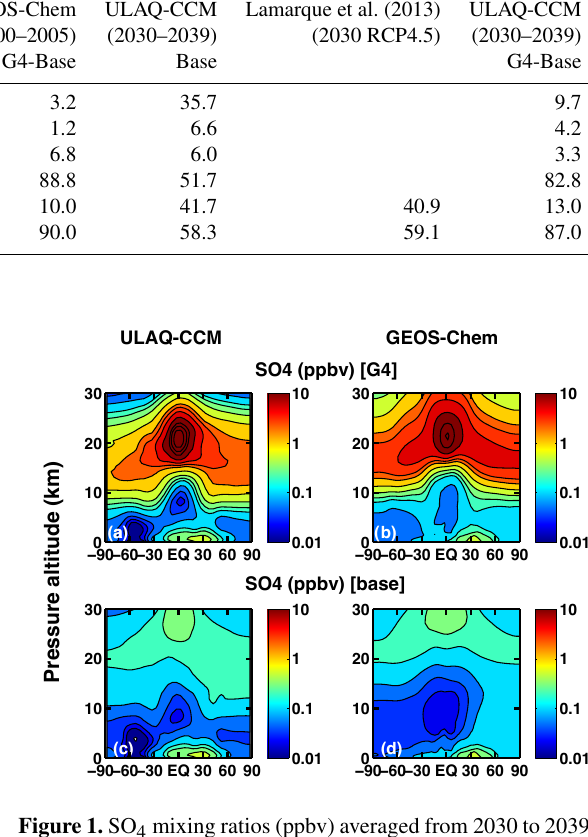
Figure 1. SO 4 mixing ratios (ppbv) averaged from 2030 to 2039 for ULAQ-CCM (a, c) and from 2000 to 2005 for GEOS-Chem (b, d) . Panels (a) and (b) are for the G4 experiment; (c) and (d) are for the Base experiment. The contour line increment is logarithmic, with three lines per